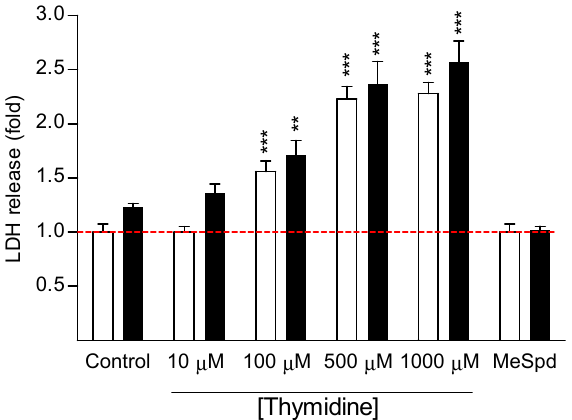
Figure 4. Cytotoxicity of thymidine to colon carcinoma CaCo2 cells. The cells were treated with 10–1000 μ M thymidine or ( S )-1-MeSpd (100 μ M, MeSpd) in the presence (black bars) or absence (white bars) of 5 mM DFMO for 4 days. LDH release to the medium was measured. Data are means ± SD, n = 6. Statistical significance ** p < 0.001, *** p < 0.001 as compared to control/DFMO group. The red dotted line indicates the level of cell growth of control cells.